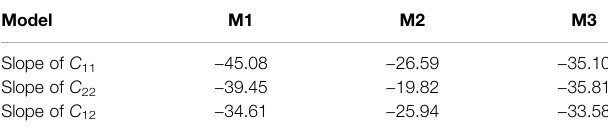
TABLE 2 | The linear- fi t slopes of the compressional elastic constants C 11 , C 22 , and C 12 with the varying layer charge density for the three models.